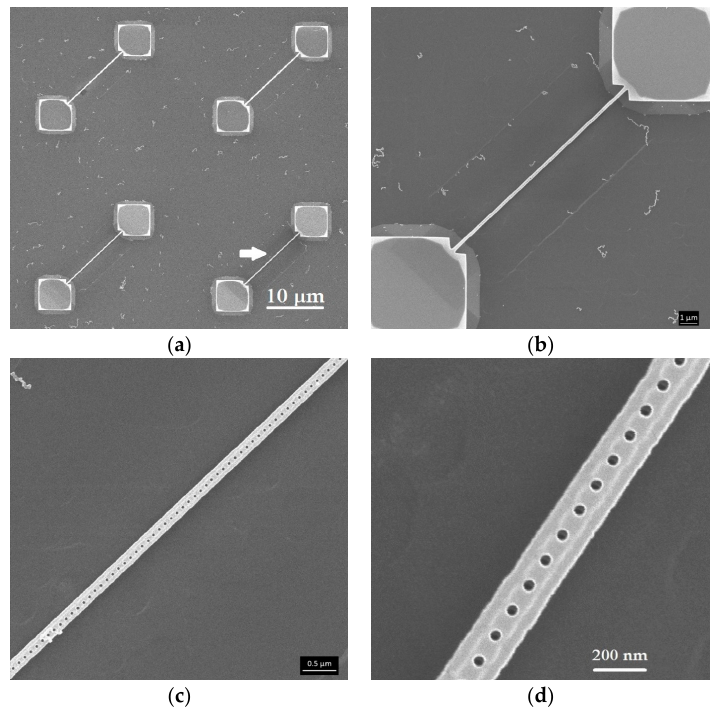
Figure 5. ( a ) Array of nanostrings with helium ion beam-milled holes; ( b – d ) High magnifications images of milled nanostring shown by arrow in ( a ).